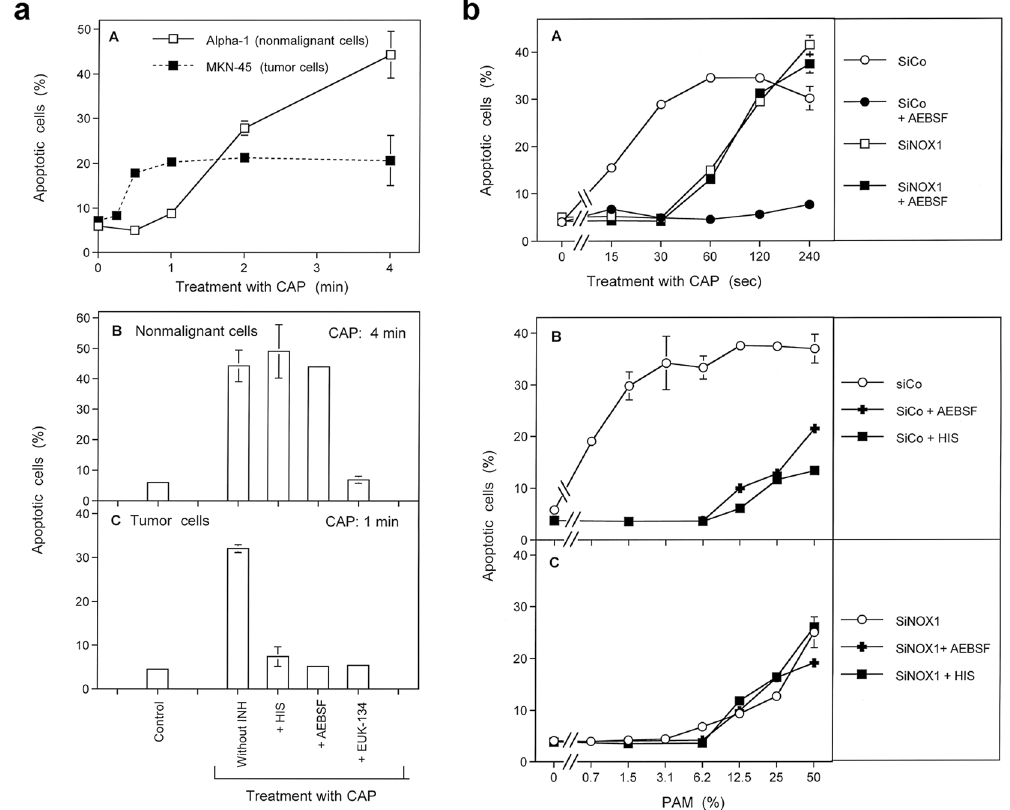
Figure 9. Differential effect of CAP on nonmalignant cells and tumor cells. ( a ) Defining the dose of selective action of CAP towards tumor cells and the underlying chemical biology. A. Nonmalignant diploid human fibroblasts (Alpha-1) and human gastric carcinoma cells (MKN-45) were treated with CAP for the indicated times. The percentages of apoptotic cells were determined after 4.5 h. The figure shows that CAP treatment up to 1 min caused apoptosis induction in tumor cells but not in nonmalignant cells. At higher times of treatment, nonmalignant cells showed a stronger response than tumor cells. This can be explained by the absence of catalase on the membrane of nonmalignant cells. B,C. Nonmalignant cells (Alpha-1) and tumor cells (MKN- 45) remained either untreated (control) or were treated with CAP for 4 or 1 min, respectively, in the absence or presence of either 50 mM of the singlet oxygen ( 1 O 2 ) scavenger histidine (HIS), or 100 µ M of the NOX1 inhibitor AEBSF or 20 µ M of the catalase mimetic EUK-134. The percentages of apoptotic cells were determined after 4.5 h. The results show that CAP-mediated apoptosis induction in nonmalignant cells seems to be directly dependent on H 2 O 2 , and is independent of 1 O 2 or NOX-derived superoxide anions (O 2 ⋅− ). In contrast, CAP- mediated apoptosis induction in tumor cells is dependent on H 2 O 2 , 1 O 2 and NOX-derived O 2 ⋅− ). Statistical analysis: A: Apoptosis induction in the tumor cells was highly significant after CAP treatment of 0.5 min, whereas highly significant apoptosis induction in nonmalignant cells required 2 min (p < 0.001). B: Apoptosis induction in nonmalignant cells was highly significant after CAP treatment (p < 0.001). Inhibition of apoptosis induction by EUK-134 was highly significant (p < 0.001), whereas there was no inhibition by histidine or AEBSF. C: Apoptosis induction in tumor cells, as well as inhibition by all three inhibitors was highly significant (p < 0.001). ( b ) Biochemical basis for selective action of CAP and PAM towards malignant cells. MKN-45 cells were treated with either irrelevant control siRNA (“SiCo”) or siRNA directed towards NOX1 (“siNOX1”) for 24 h. This causes knockdown of NOX1 activity to less than 5% residual activity. As the expression of membrane- associated catalase is controlled by NOX1-derived superoxide anions (O 2 ⋅− ) and their dismutation product H 2 O 2 , siNOX1 cells are no longer protected by membrane-associated catalase 12 . Therefore, siCo cells show the phenotype of tumor cells, whereas siNOX1 cells resemble nonmalignant cells with respect to the redox biology at their membrane. A. SiCo and SiNOX1 cells were treated with CAP for increasing time, in the absence or presence of the NOX1 inhibitor AEBSF. The percentages of apoptotic cells were determined after 4 h. The results show that siNOX cells were reacting more sensitive to CAP treatment than siCo cells. Whereas the response of siCo cells depended on NOX1, the reaction of siNOX1 cells was not sensitive to the NOX inhibitor. Taken together, CAP treatment up to 1 min defines a window in which selective apoptosis induction in tumor cells can be achieved, whereas higher treatment times do not allow differential apoptosis induction in malignant and nonmalignant cells. B,C. SiCo and SiNOX1 cells were treated with increasing concentrations of PAM (generated through 1 min treatment of medium with CAP), in the absence and presence of the NOX1 inhibitor AEBSF or the 1 O 2 scavenger histidine (HIS). The percentages of apoptotic cells were determined after 4 h. The results define a window of selectivity of PAM action towards tumor cells compared to nonmalignant controls. Selective apoptosis induction in tumor cells was dependent on 1 O 2 and NOX1-derived O 2 ⋅− , whereas apoptosis